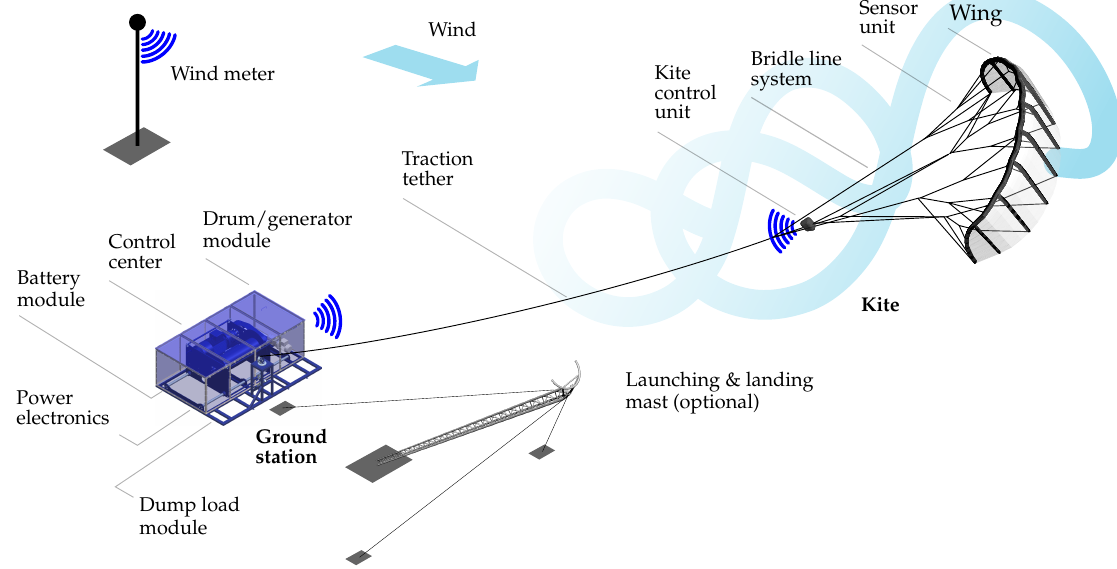
Figure 2. Airborne wind energy system components